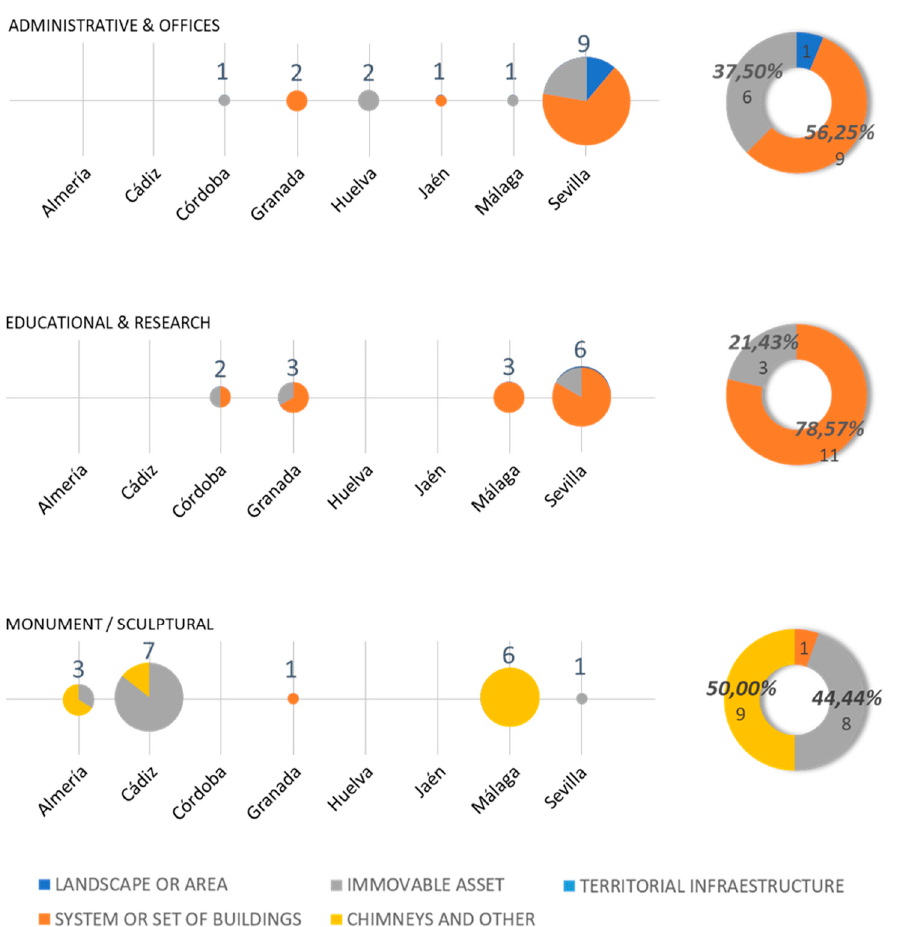
Figure 12. Distribution of assets within the new uses with a significant number of assets and considering the location and the scale criteria.